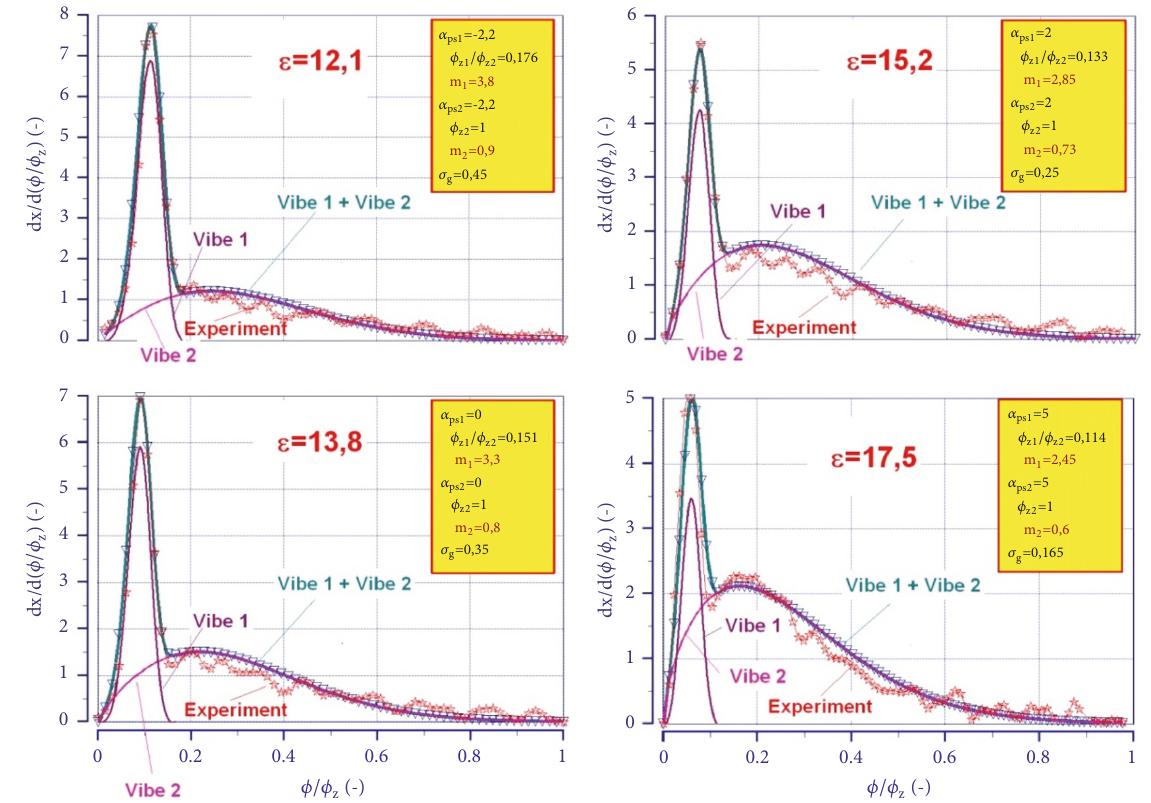
Figure 5: Experimental and theoretical rateof heatreleasediagrams of experimental diesel engine underspeeds of n=1960 rpm, fuel injection angle 18.5 (deg CA), BMEP=0.55MPa. ( 𝛼 and 𝛼 ) are angle of initial (start) of combustion (2% of burned mass) for the first and second ps 1 ps 2 Vibe function,